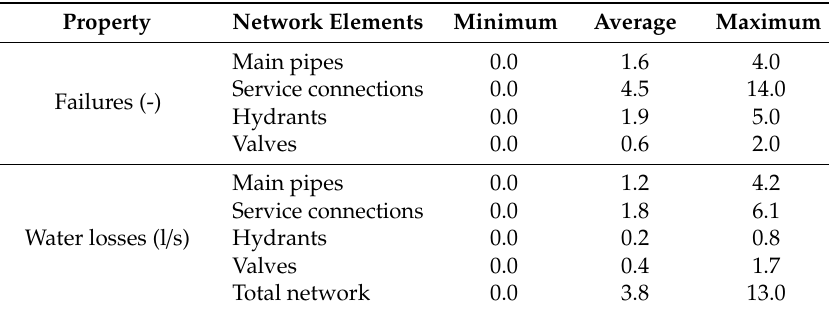
Table 3. Results of the leakage detection